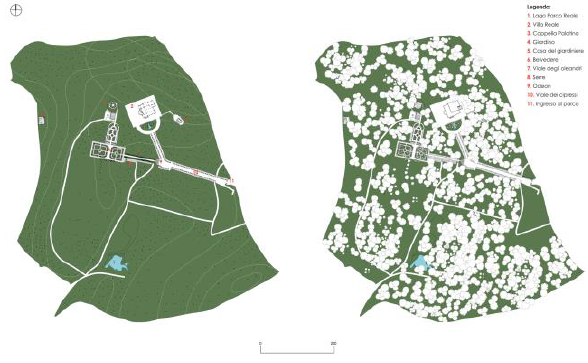
Figure 1. The Royal Park of Tirana. General plan with typology identification (on the left) and roof planimetry (on the